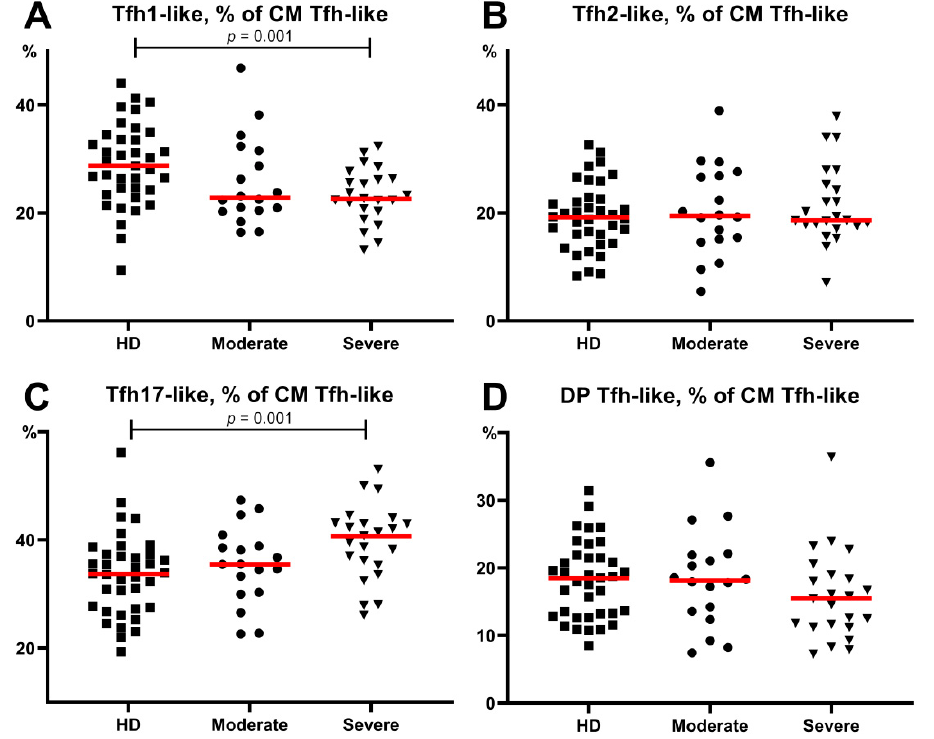
Figure 7. Relative count of Tfh-like cell subsets, calculated from CM Tfh-like cells. ( A ) Relative count of Tfh1-like cells. ( B ) Relative count of Tfh2-like cells. ( C ) Relative count of Tfh17-like cells. ( D ) Relative count of DP Tfh-like cells. CM, central memory; Tfh, follicular Th-like cells; DP, double positive Th17-like cells (expressing CXCR3 and CCR4). Red lines demonstrate Median value.